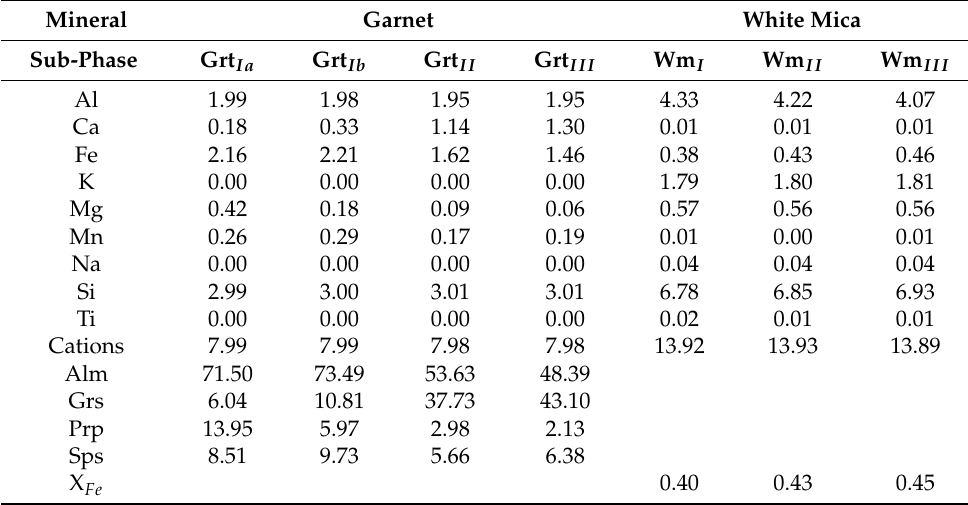
Table 4. Average compositions of minerals from Rocca Canavese obtained via Q-XRMA. All val- ues are calculated on the base of 1528 calibrated pixels for Grt Ia ; 218 calibrated pixels for Grt Ib ; 387 calibrated pixels for Grt II and 1299 calibrated pixels for Grt III ; 1100 calibrated pixels for Wm I